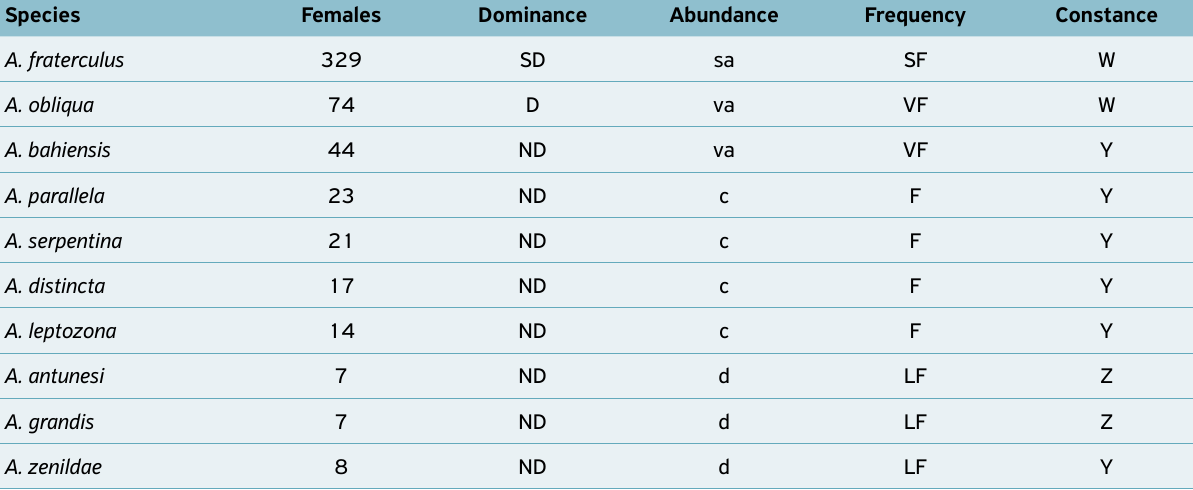
Table 1. Faunistic analysis of Anastrepha species captured in McPhail traps in Ilhéus, July/2011 – December 2012. Species Females Dominance